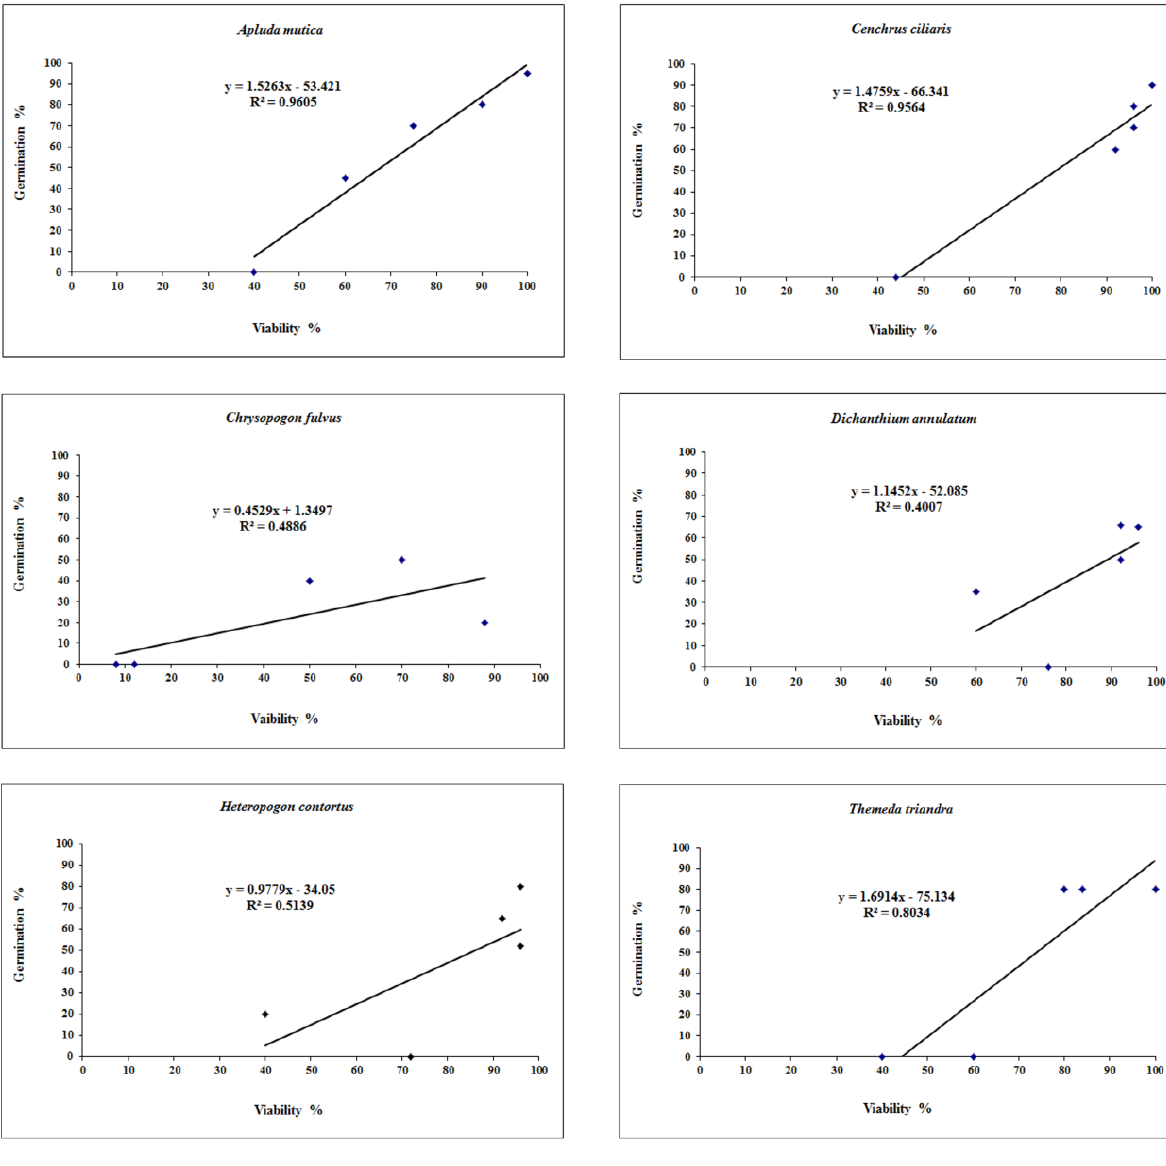
Fig. 2. Correlation between viability and